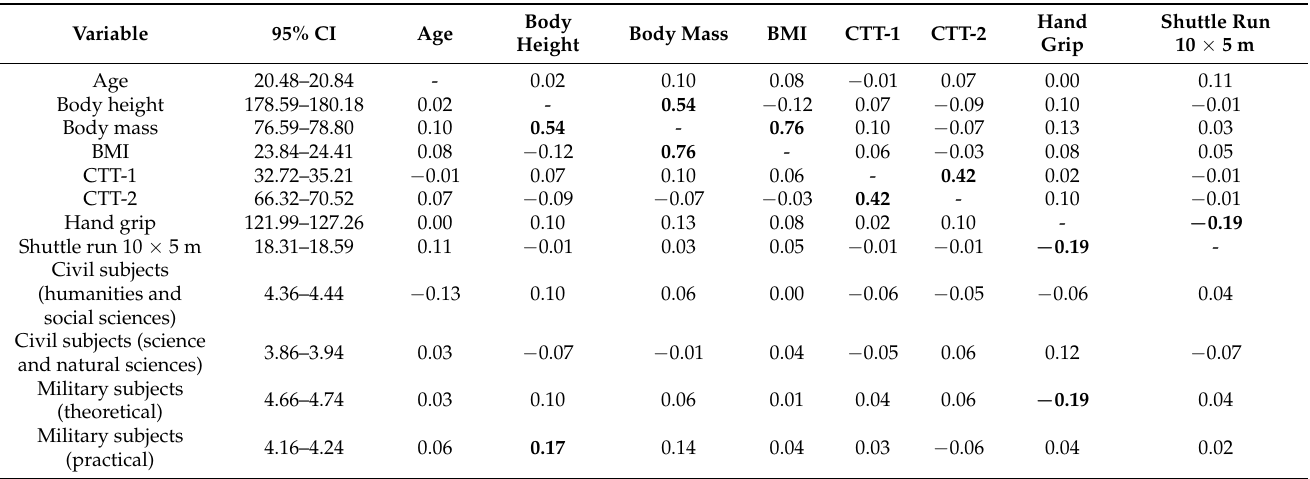
Table 3. Associations between the studied characteristics in the male group. Correlation coefficients highlighted in bold are significant with p <